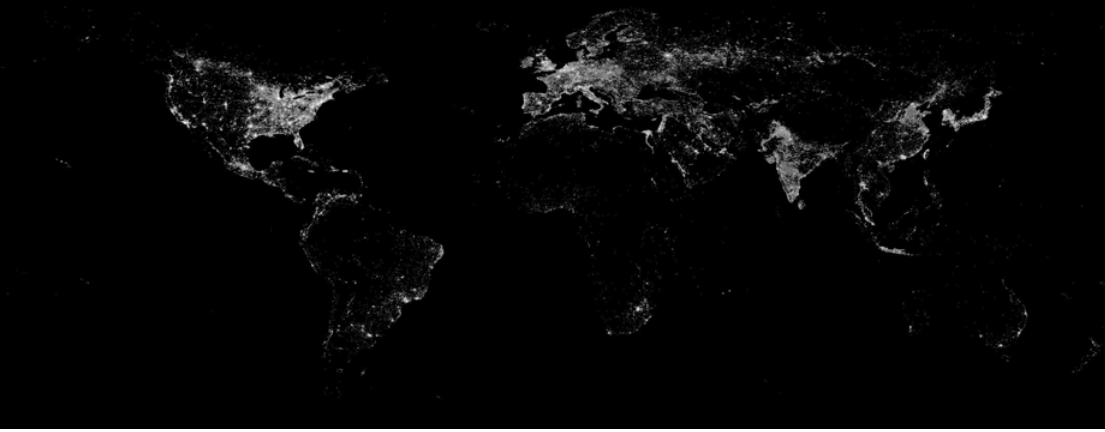
The spatial resolution of the smoothed nighttime lights data is 2.7 km. However, the images are geolocated to 30 arc-second grids, which is approximately 1 km 2 at the equator. The latitudinal extent of the image is from 75°N to 65°S and the longitudinal extent is from 180°W to